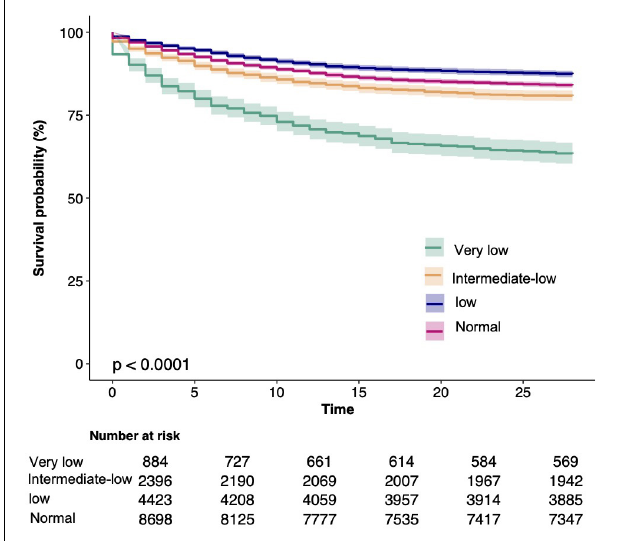
FIGURE 2 | Kaplan-Meier Survival Curves for day 28 of sepsis patients depending on the platelet count.